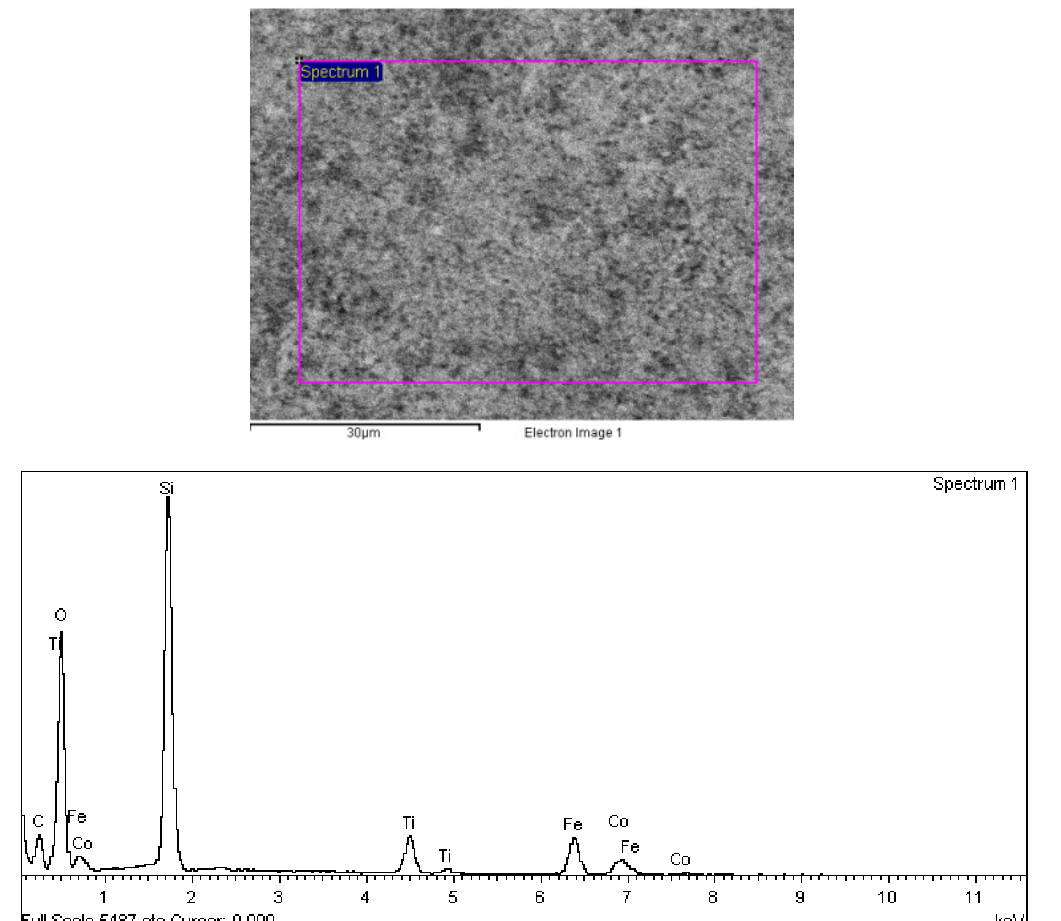
Figure 8. Energy Dispersive X-Ray (EDX) analysis of the TiO 2 /SiO 2 coated CoFe 2 O 4